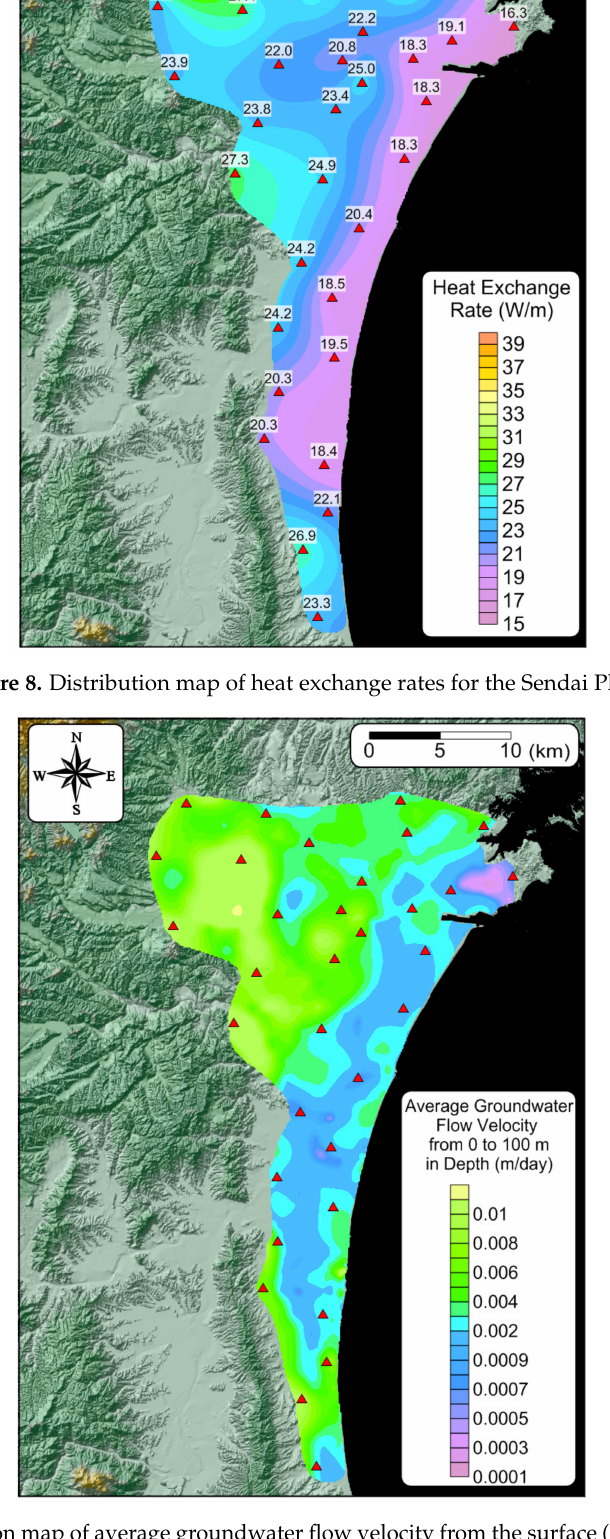
Figure 9. Distribution map of average groundwater flow velocity from the surface (0 m) to 100 m depth for the Sendai